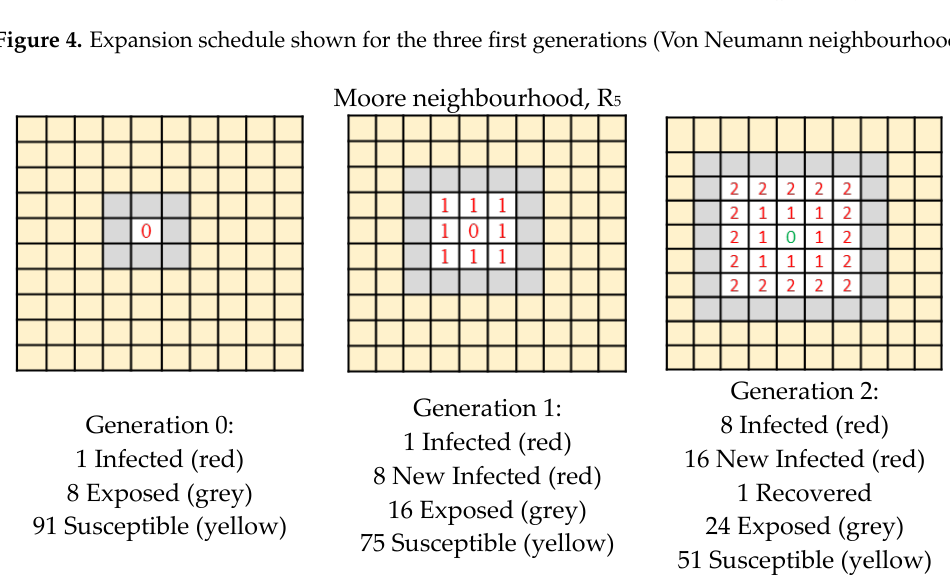
Figure 5. Expansion schedule shown for the three first generations (Moore neighbourhood) .